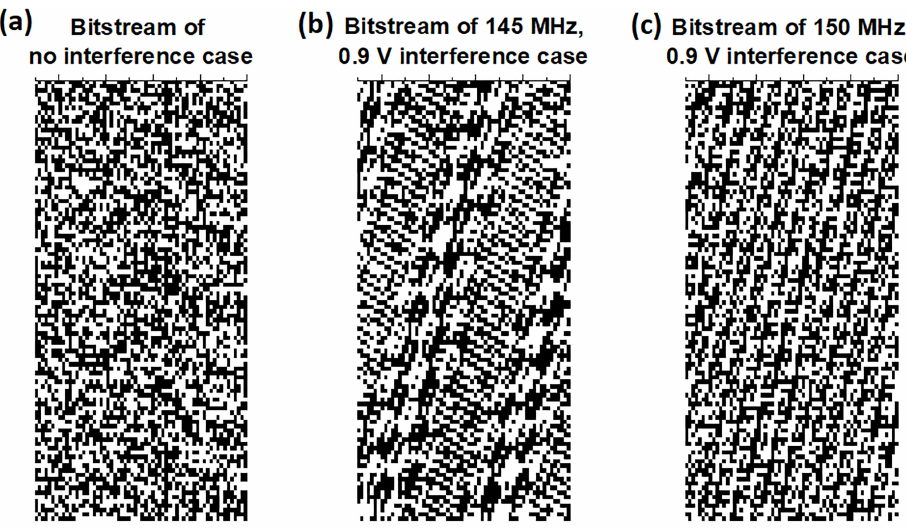
Figure 17. Bitstream of the TRNG under selected interference conditions: ( a ) no interference; ( b ) condition of ( A RFI , f RFI ) = (0.9 V, 145 MHz); ( c ) condition of ( A RFI , f RFI ) = (0.9 V, 150